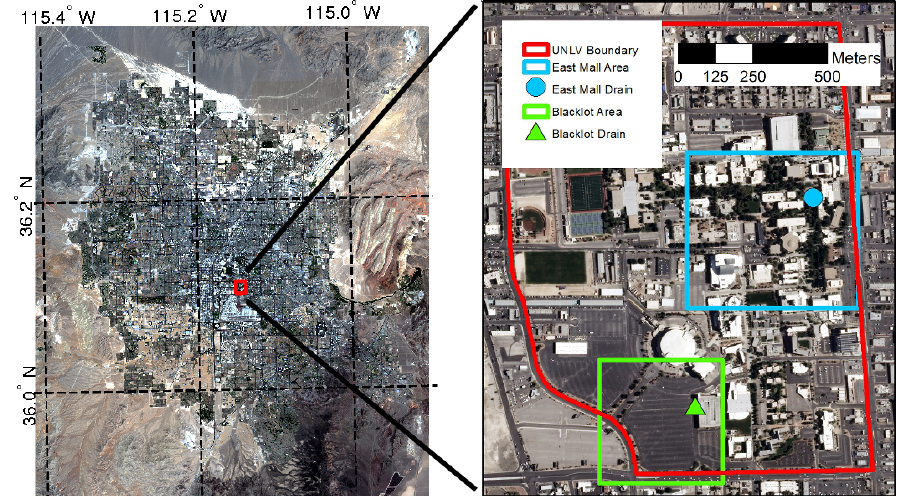
Figure 5. Map showing Blacklot and East Mall study